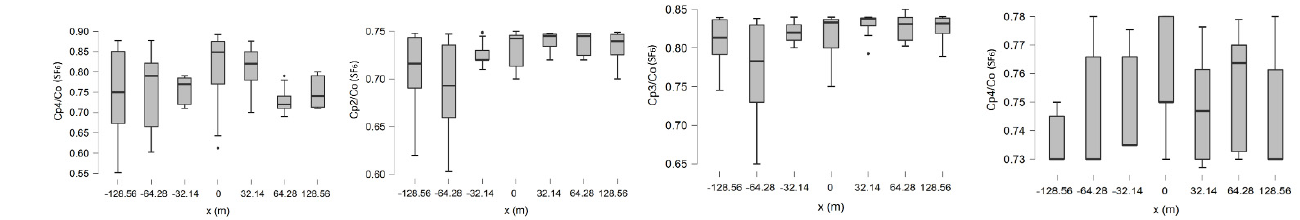
Figure 2. Cp/Co for SF 6 using CALRANS99 (Data 1) for unstable atmospheric conditions concerning the downwind distances.